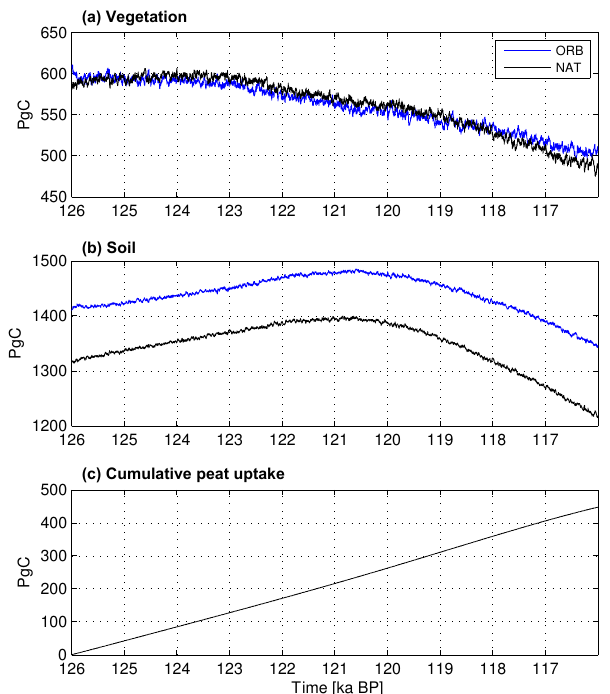
Figure 7. Disaggregation of the net carbon fluxes in the Eemian experiments: geological flux to atmosphere (a) , land–atmosphere flux (b) and ocean–atmosphere flux (c) . Plots have been smoothed for clarity.